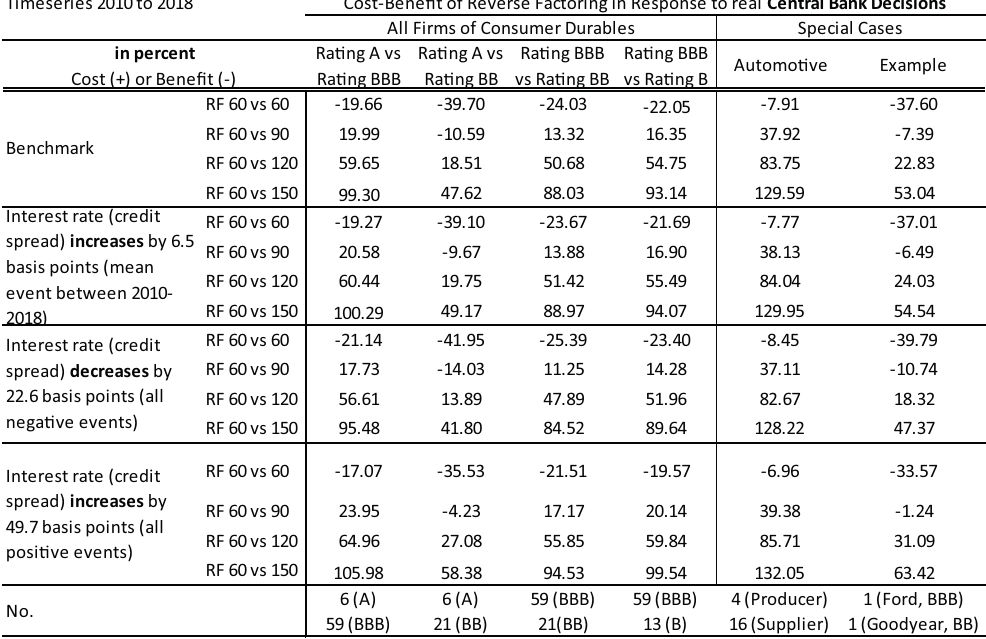
Table 4. Simulation event study—adaption to central banks’ interest rates. Source: Authors’